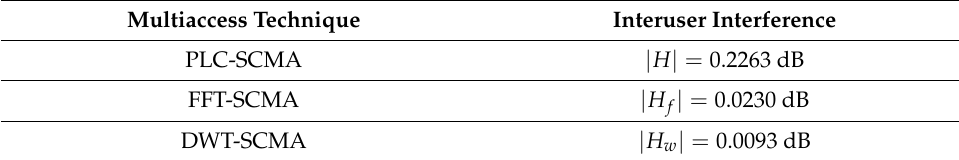
Table 1. Interuser Interference comparison.